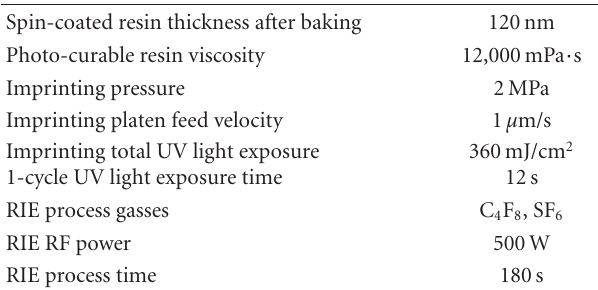
Table 2: Imprinting